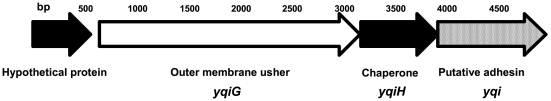
Physical map showing genomic organization of the 4,975 bp yqi adhesin gene cluster in APEC strain IMT5155.A hypothetical protein preceeds the putative outer membrane usher protein, followed by the putative chaperone and finally the putative adhesin.